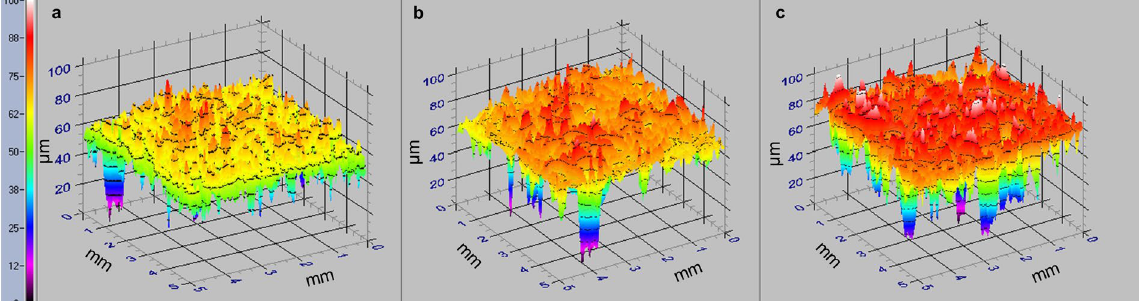
Figure 3. 3D models derived using the TRACEiT ® optical scanner for surfaces of Elm Park Limestone exposed to: ( a ) no weathering (control); ( b ) an ivy covered frost weathering regime and ( c ) an exposed stone (no ivy) frost weathering regime. In each case a 5 × 5 mm area is shown, with vertical height (Z) deviation represented in colour shading between 0 and 100 µ